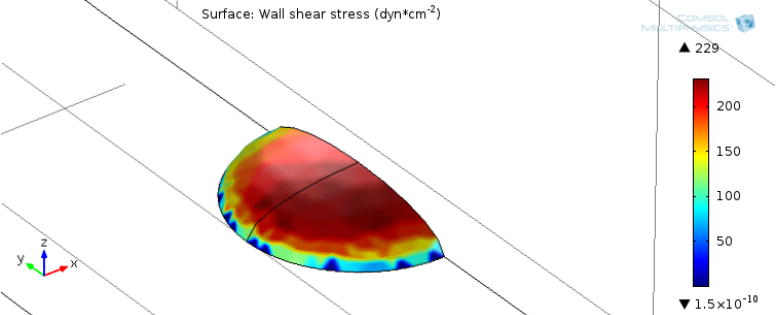
Figure A1. Simulation results for shear stress distribution across the cell membrane. The model assumes symmetry and simulates only half of the cell membrane. Shear stress (dyne/cm 2 ) is plotted only on the cell membrane area and is maximized at the top of the dome. Cell dimensions: 18 µm radius, 5 µm height. Nanomaterials 2018 , 8 , x FOR PEER REVIEW